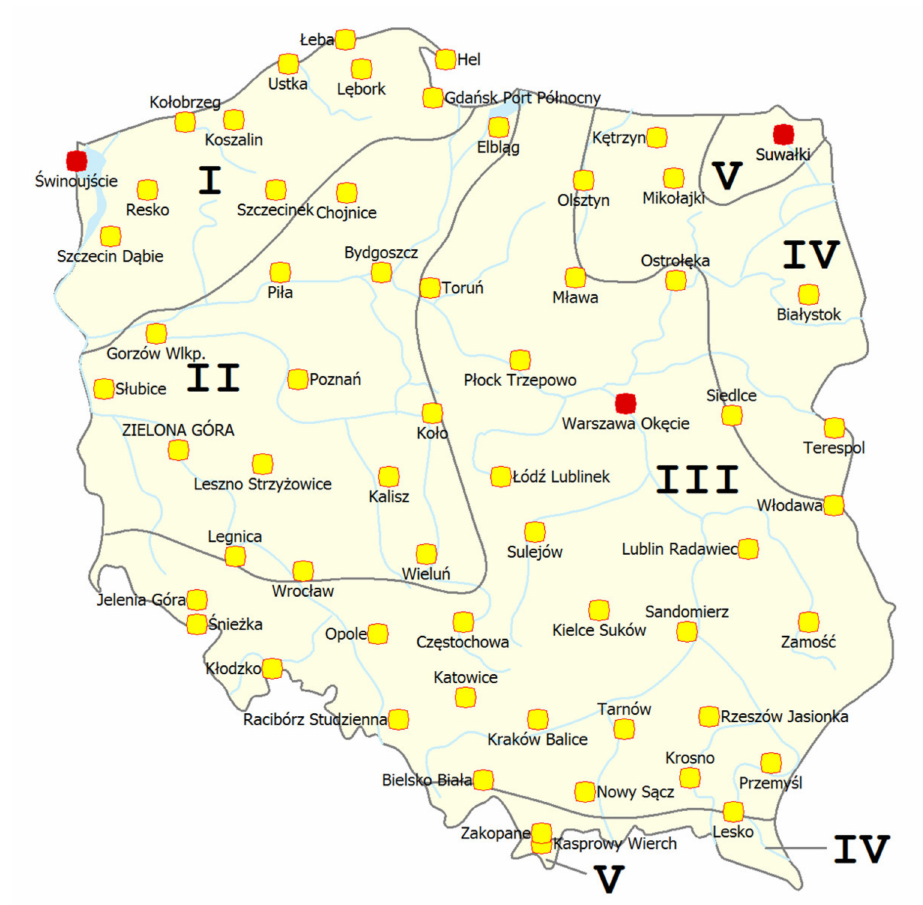
Figure 1. Map showing the locations of 61 meteorological stations for which weather data were developed. The map shows typical meteorological years for calculating the energy performance of buildings. The selected location—Warsaw—is marked in red. Climatic zones I–V are marked on the map, as per PN-EN 12831-1:2017-08. Source: Audytor